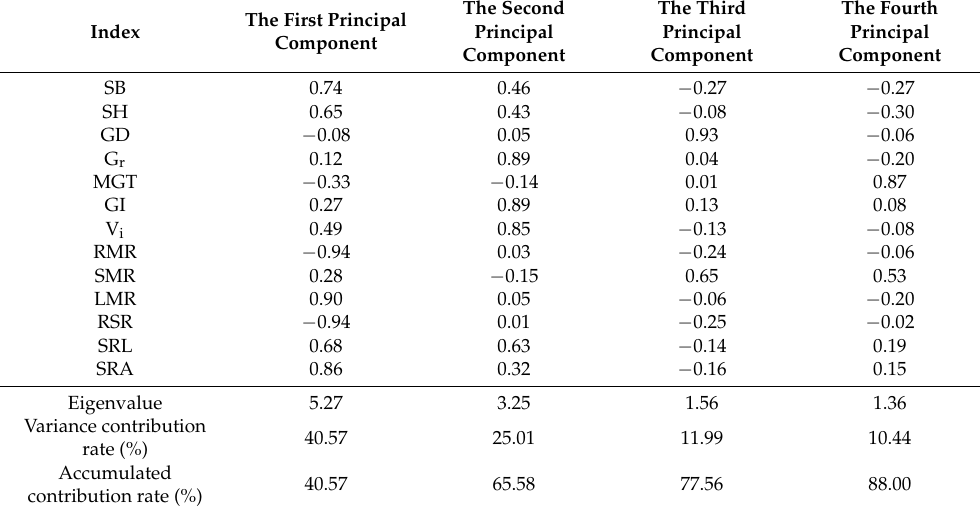
Table 3. Coefficient, eigenvalue, variance contribution rate, and accumulated contribution rate of principal components. SB: seedling biomass; SH; seedling; height; GD: ground diameter; G r : germination rate; MGT: mean germination time; G i : germination index; V i : vigor index; RMR: root mass ratio; SMR: stem mass ratio; LMR: leaf mass ratio; RSR: root/shoot ratio; SRL: specific root length; SRA: